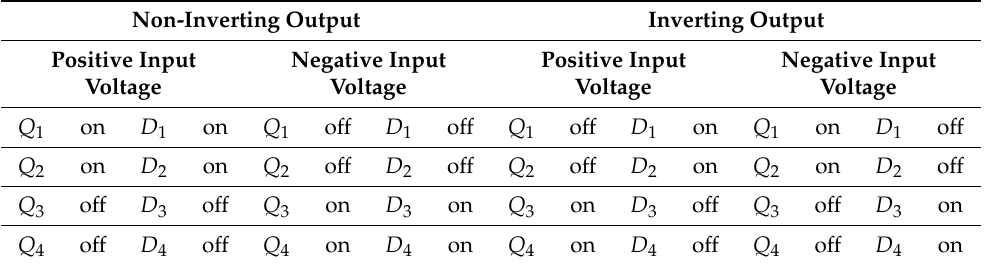
Table 1. Operating states of solid-state devices for output in-phase and output of phase